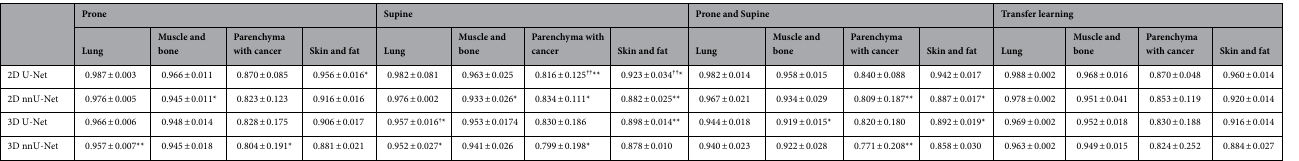
Table 1. Comparison of DSC results of models between prone and supine as well as among transfer learning vs prone, supine, and prone to supine, respectively. Wilcoxon tests were performed results between prone and supine † , as well as among transfer learning vs prone, supine, and prone to supine*, respectively; † , *, p -value < 0.05; †† , **, p -value < 0.001; DSC, Dice similarity coefficient.